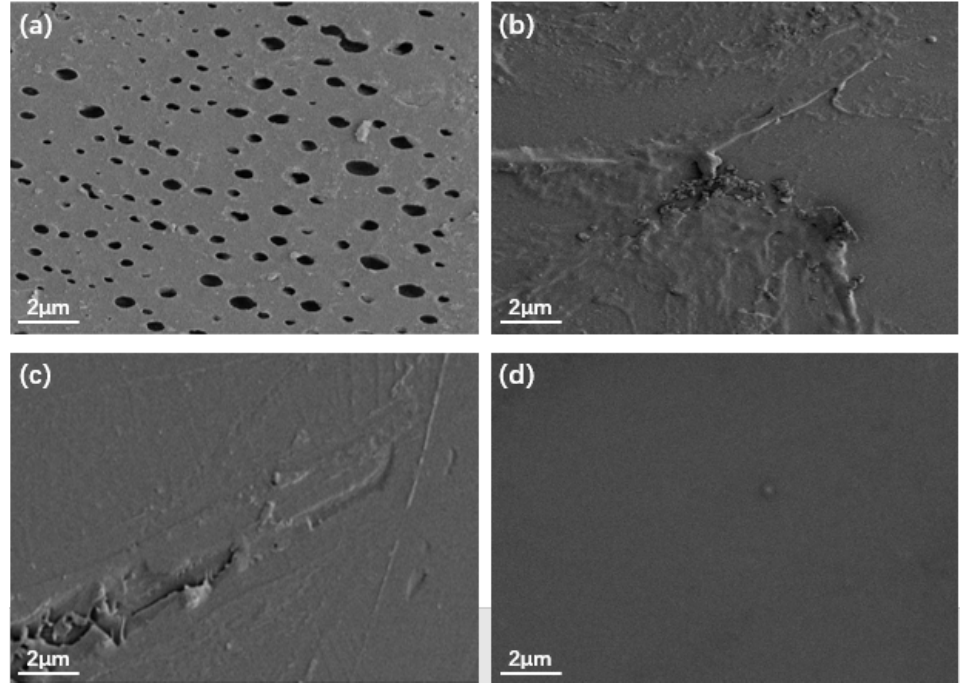
Figure 5. SEM images of ( a ) EP, ( b ) TiO 2/ GO/EP, ( c ) TiO 2 /PANI/EP, ( d ) TiO 2 /GO/PANI/EP.